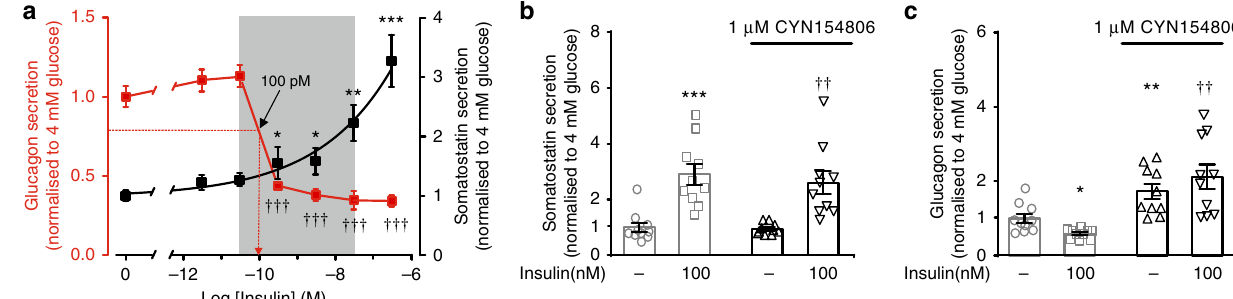
Fig. 2 Insulin exerts its glucagonostatic effect by somatostatin. a Effects of increasing concentrations of insulin (3 pM, 30 pM, 300 pM, 3 nM, 30 nM, 300 nM; logarithmic abscissa) on glucagon (red) and somatostatin (black) secretion in the presence of 4 mM glucose ( n = 10 experiments/6 male mice). Arrow indicates IC 50 for inhibitory effect of insulin on glucagon secretion (~100 pM). * p < 0.05, ** p < 0.01 and *** p < 0.001 and ††† p < 0.001 for the effects of insulin on somatostatin and glucagon secretion vs 4 mM glucose alone, respectively, one-way ANOVA followed by Dunnet ’ s post hoc test. b Somatostatin secretion at 4 mM glucose in the absence and presence of insulin and/or CYN154806 ( n = 10 experiments//6 male mice). *** p < 0.001 vs 4 mM glucose; †† p < 0.005 vs 4 mM glucose and CYN154806, one-way ANOVA followed by Dunnet ’ s post hoc test. c As in b but glucagon is measured ( n = 10 experiments/6 male mice). Secretion has been normalised to secretion rates at 4 mM glucose. * p < 0.05 and ** p < 0.01 vs 4 mM glucose; †† p < 0.005 vs 4 mM glucose and insulin. Data are presented as dot plots of individual experiments and/or mean values ± S.E.M. of all experiments with the experimental series male and female SIRKO mice in vivo are therefore likely to re fl ect of glucose or insulin on glucagon and somatostatin secretion in systemic rather than intra-islet mechanisms. Interestingly, the isolated islets from male and female SIRKO mice (Supplementary counter-regulatory response also shows a sex difference in Fig. 3c-f). For this reason, hormone secretion data from male and humans 23,24 . female mice were pooled. Thus, the differences observed between